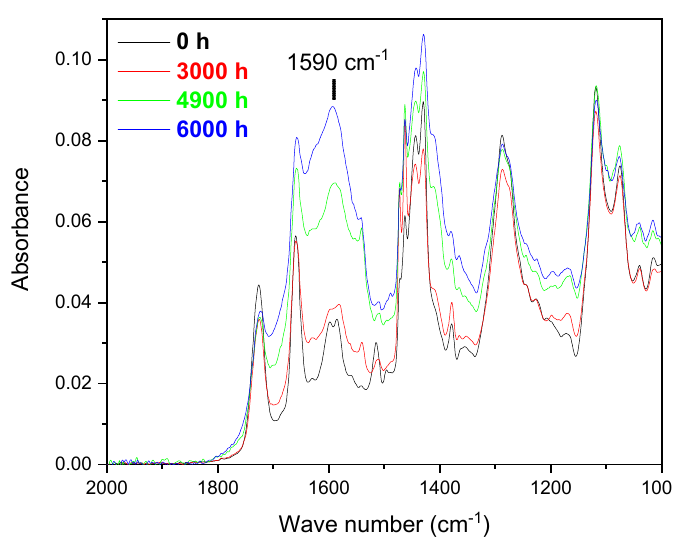
◦ C for di ff erent